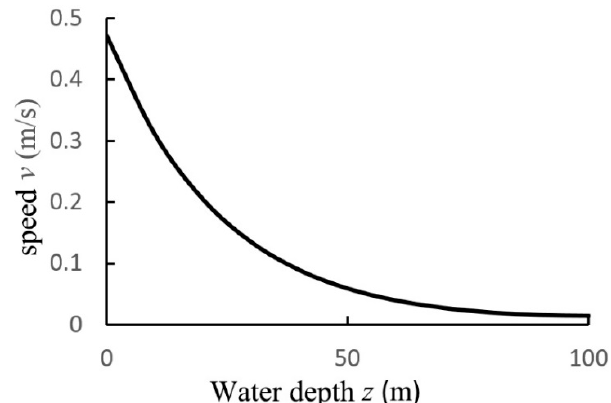
Figure 2. Maximum horizontal velocity of water quality points at different water depths.